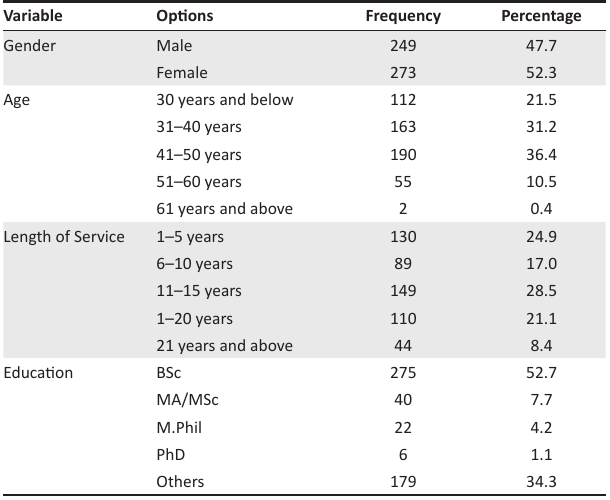
TABLE 1: Descriptive statistics of the demographic